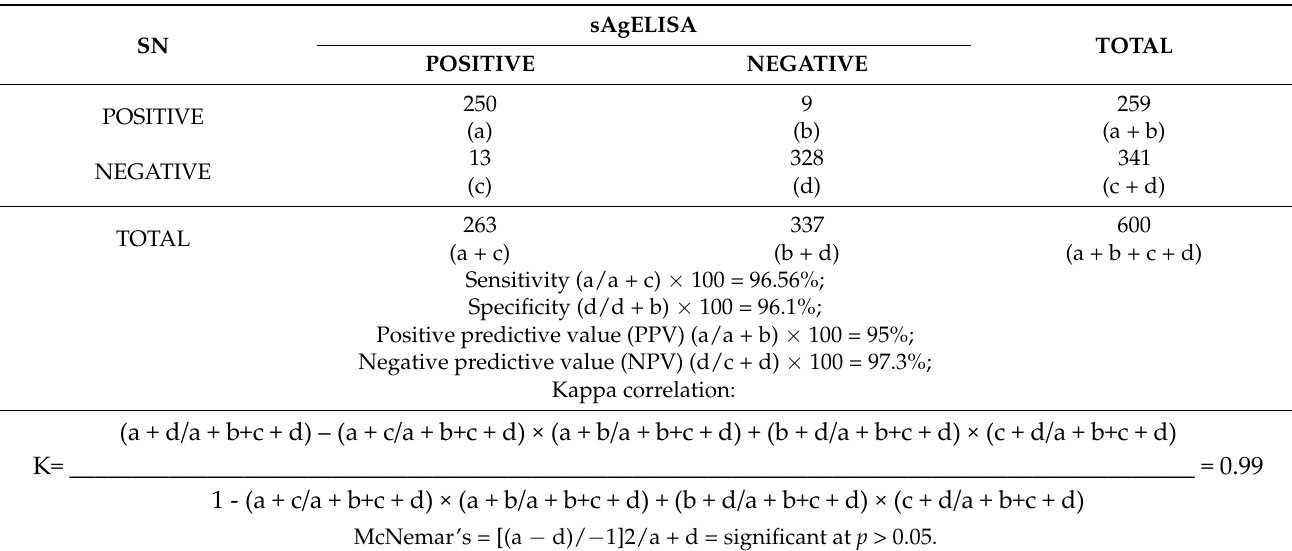
Table 2. Comparison between serum neutralization (SN) and sAgELISAs for detection of antibodies to alphaherpesviruses in bovine sera (n = 600).